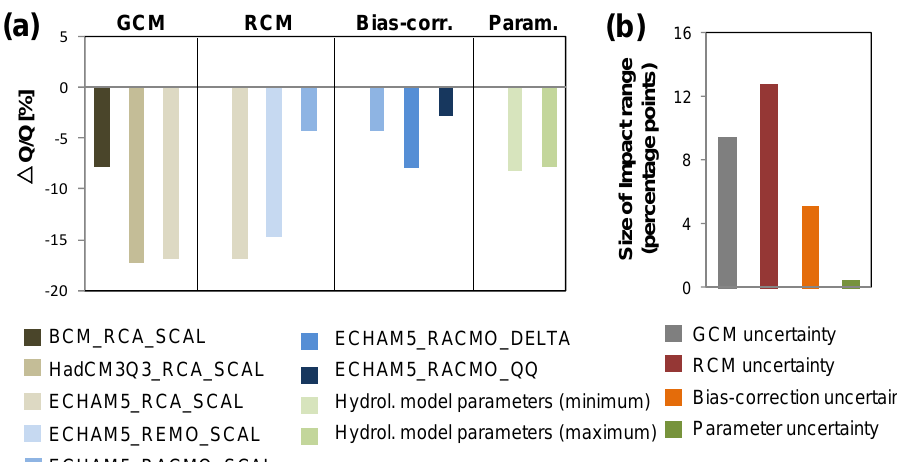
Fig. 7. (a) Uncertainty in the projection of mean annual runoff ( Q ) resulting from GCM, RCM, bias-correction and hydrological model parameters. (b) Size of impact range originating from each uncertainty source. The differences (percentage points) between the minimum and maximum values are plotted.